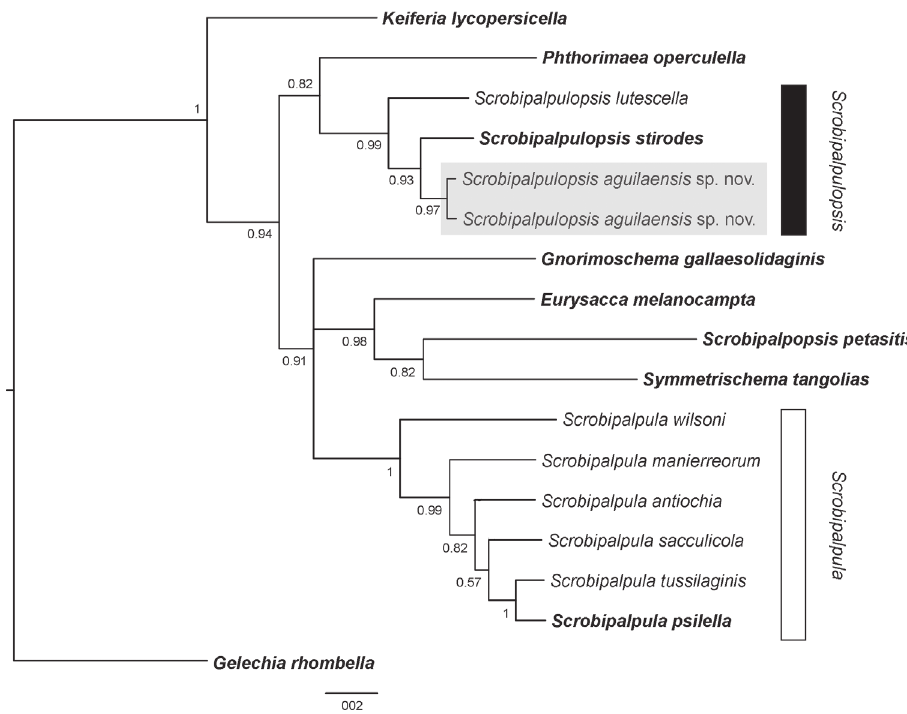
Figure 1. Bayesian consensus tree of Scrobipalpulopsis aguilaensis sp. nov. (grey rectangle) and representatives of Gnorimoschemini based on mitochondrial DNA sequences. The type species of Gelechia Hübner, [1825] (Gelechiini) was used to root the tree. Type species in bold. Posterior probability values indicate node